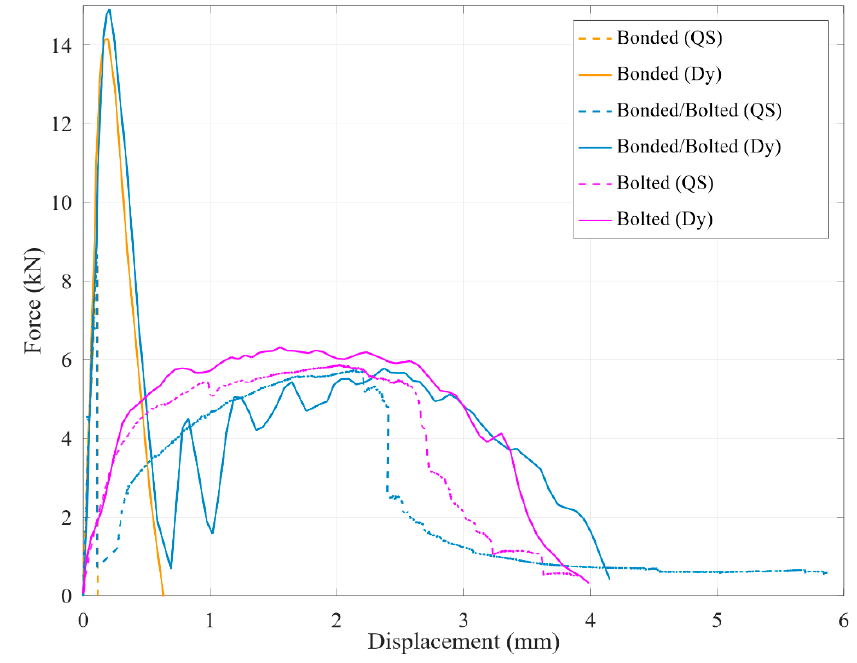
Figure 17. Force–displacement curves of one representative of each kind of joint (QS—quasi-static and Dy—high-rate).